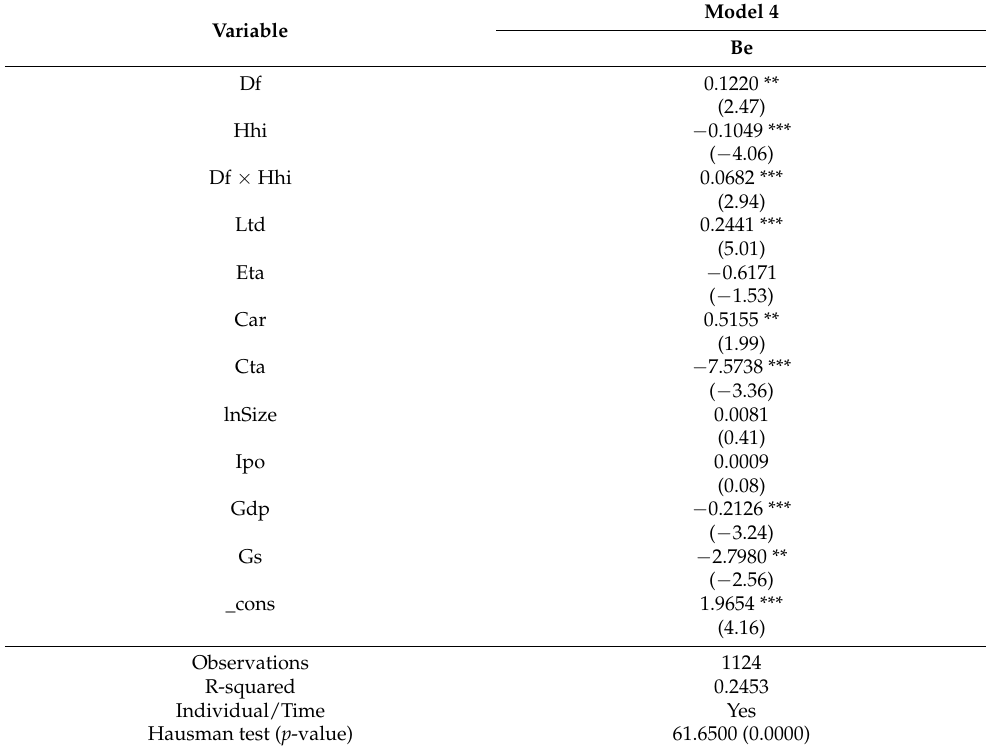
Table 10. Test of the moderating effect.